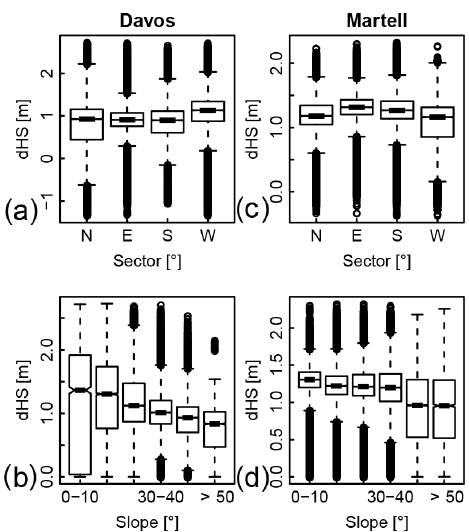
Figure 7. Box plots relating dHS to aspect (a, c) and slope (b, d) of the spring survey for Flüela (a, b) and Martell (c, d)